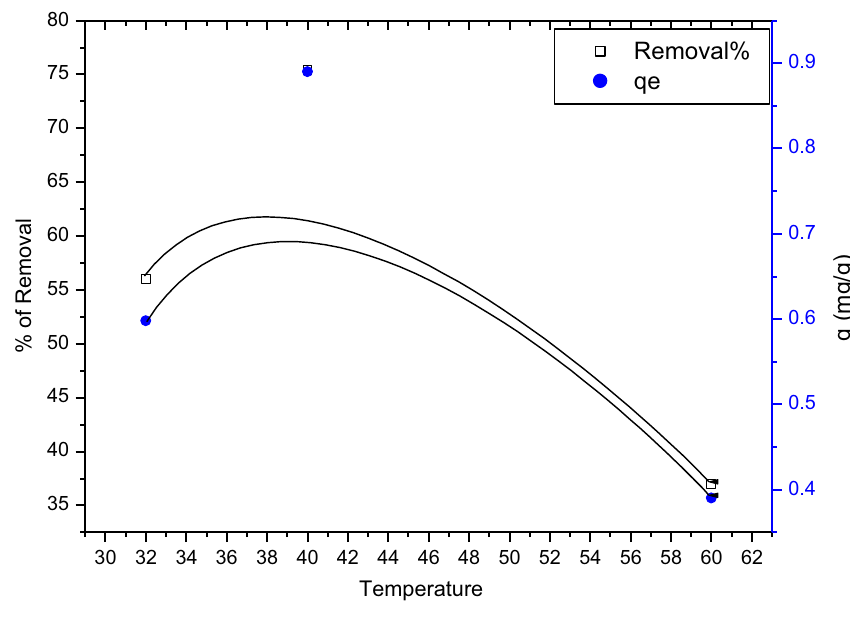
Fig. 9 Effect of temperature on the adsorption of CR dye by